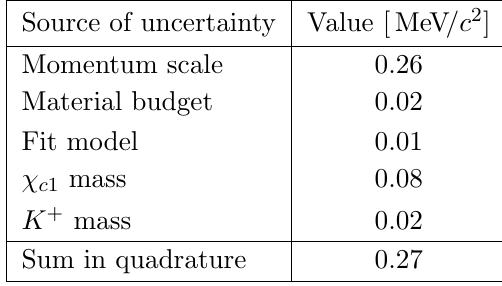
Table 3 . Systematic uncertainties on the B 0